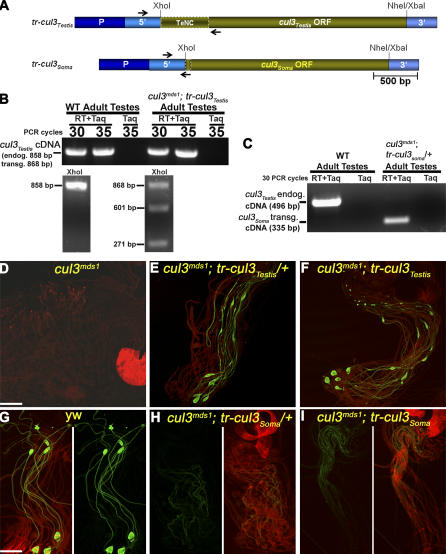

cul3Testis but Not cul3Soma Can Restore Caspase Activation and Spermatid Individualization to cul3Testis Null Mutants(A) Schematic structure of the rescue constructs for cul3Testis
−/− male sterile flies. The constructs tr-cul3Testis and tr-cul3Soma are composed of the cul3Testis isoform's promoter region (dark blue, consists of the intronic sequences flanked by exons 2 and 1D) and 5′ UTR (light blue) that were fused upstream of the coding regions (ORFs) of either cul3Testis or cul3Soma followed by the 3′ UTR of cul3Testis.(B and C) Transcriptional expression from the transgenes was confirmed by RT–PCR analyses on RNA from testes of the indicated genotypes. The relative locations of the primers are indicated with black arrows in (A). “RT+Taq” and “Taq” indicate reactions with reverse transcriptase or without it, respectively, to control for possible genomic DNA contamination.(B) To differentiate between the cul3Testis endogenous (endog.) and transgenic (transg.) cDNAs, we cleaved the RT-PCR fragments with XhoI, a unique restriction site in the transgene. Note that the RT-PCR product from cul3mds1; tr-cul3Testis but not from WT testes was cleaved by XhoI, confirming its transgenic source.(C) Transgenic expression of cul3Soma (tr-cul3Soma) in adult testis. Note the absence of the endogenous cul3Testis cDNA band and in contrast, the presence of the transgenic cul3Soma band in cul3mds1; tr-cul3Soma/+ testes.(D–I) Testes stained for cleaved caspase-3 (CM1, green) and spermatid's tail and ICs (phalloidin, red).(D) Mutant spermatids for cul3Testis (cul3mds1
−/−) manifest a block in caspase activation and spermatid individualization.(E) Either one or (F) two copies of transgenic cul3Testis (tr-cul3Testis) restores caspase activation, spermatid individualization, and fertility of cul3mds1
−/− male flies.(G) Wild-type control testes. Note the CBs and WBs (green oval structures).(H–I) In contrast, dramatically reduced CM1-positive cysts are found in cul3mds1 mutants, which ectopically express (H) one or (I) two copies of the cul3Soma transgene (tr-cul3Soma). These spermatids failed to individualize, no CBs and WBs are detected and the males are sterile. Scale bars 200 μm.